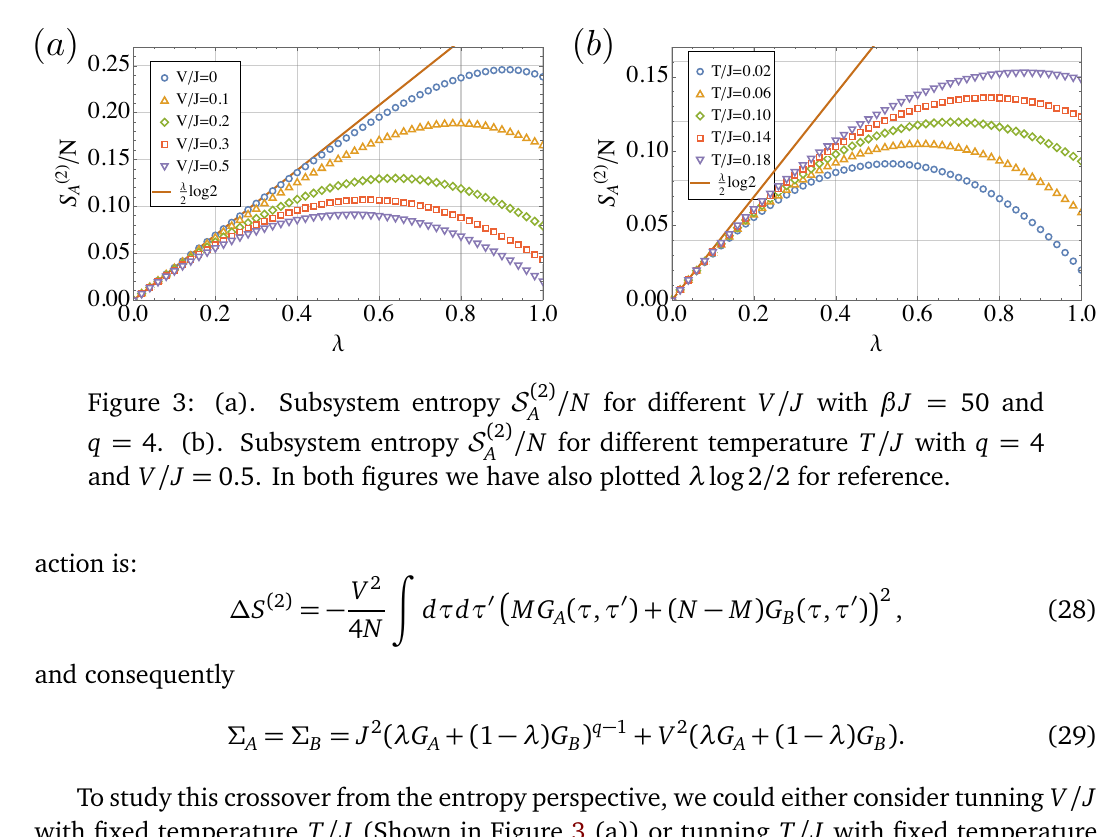
Figure 3: (a). Subsystem entropy S q = 4. (b). Subsystem entropy S